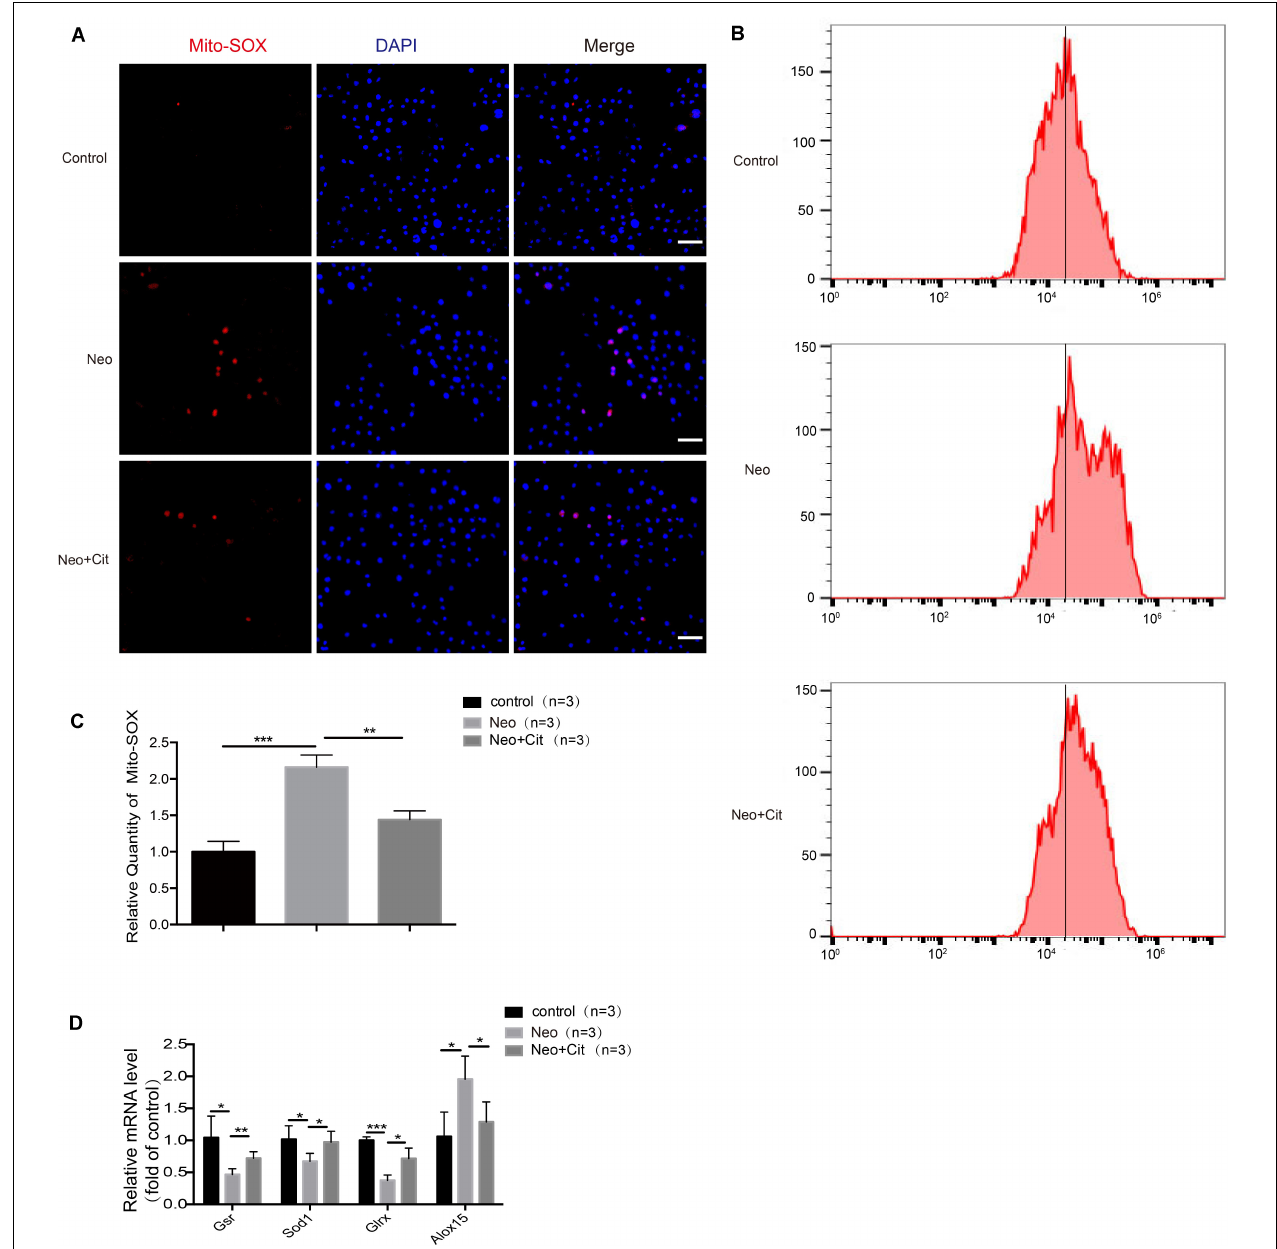
FIGURE 7 | Citicoline modulates neomycin-induced oxidative stress in HEI-OC-1 cells. (A) The three groups of HEI-OC-1 cells were labeled using the Mito-SOX Red staining kit. (B) Flow cytometry data confirmed the results in (A) . (C) Quantification of the flow cytometry results in (B) . The ROS levels were significantly increased after neomycin treatment compared to the undamaged group. The ROS levels induced by neomycin were significantly reduced by pretreatment with citicoline. (D) The mRNA levels of genes related to redox reactions were analyzed by qRT-PCR and normalized to GAPDH and presented as the fold change compared to control levels. Data are shown as mean ± SD. * p < 0.05, ** p < 0.01, *** p < 0.001. Scale bars = 20 µ